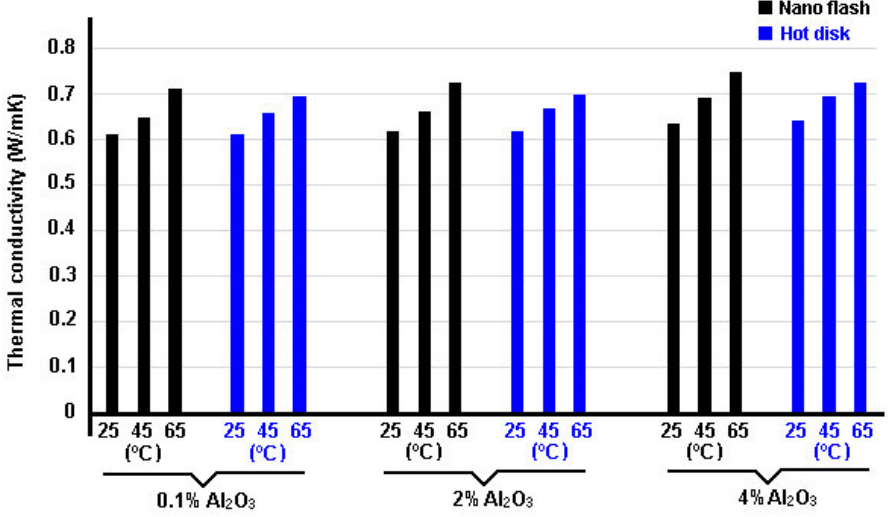
Figure 16. Thermal conductivity data obtained by Buonomo et al. [113] for the Al 2 O 3 -water using the flash and hot disk techniques.